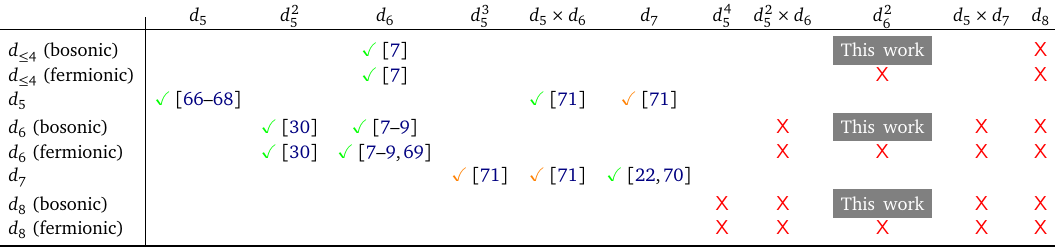
Table 5: State of the art of SMEFT renormalisation. The rows represent the opera- tors (defined by their dimension d ) being renormalised, while the columns show the operators entering the loops. Note that there are no bosonic interactions at odd di- mension. Blank entries vanish. A tick (cid:216) represents that the complete contribution is known. The (cid:216) indicates that only (but substantial) partial results have been already obtained. The X indicates that nothing, or very little, is known. The contribution made in this paper is marked by . d